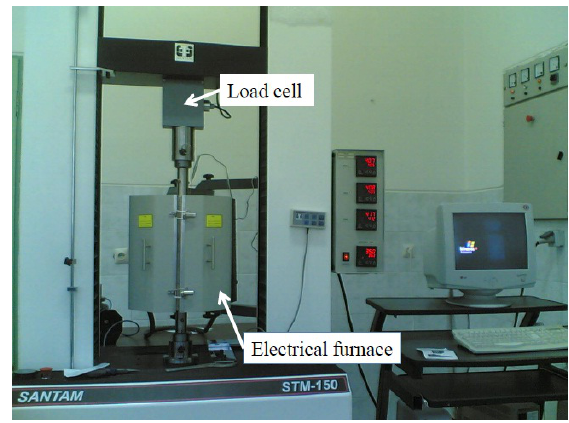
Figure 1: The 150 KN Santam testing machine used in this research.